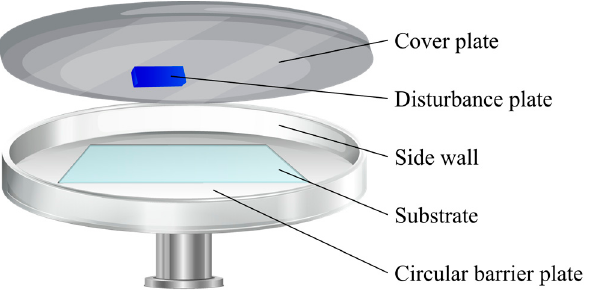
Figure 1. Schematic diagram of the rotating system of the spin coater. The cover plate and the side wall are fixed without relative movement and form a closed spin coating chamber.